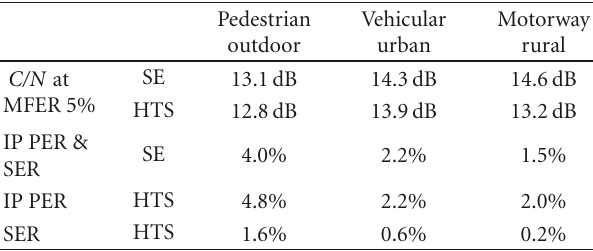
Table 1: Carrier-to-noise ratios, IP packet error ratios, and byte error ratios at MFER 5% in the di ff erent channels.